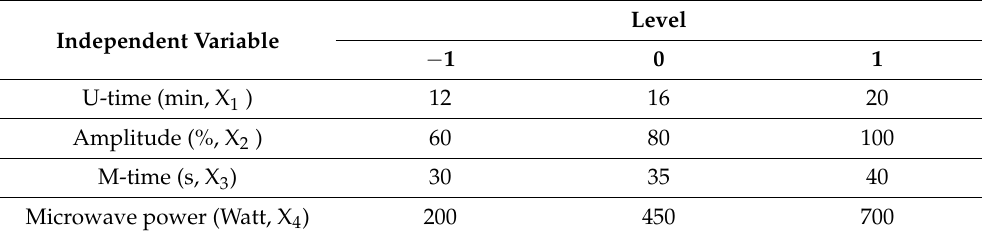
Table 1. Independent variable values and their corresponding proportions used in